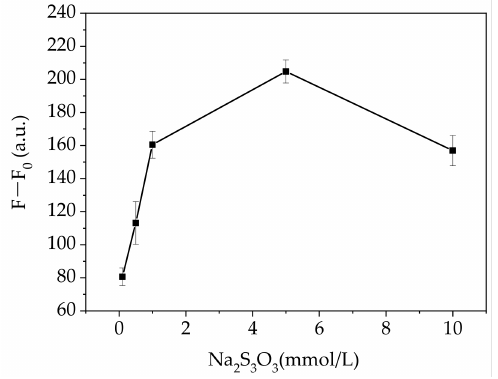
Figure 7. Effect of Na 2 S 2 O 3 concentration on Pb 2+ sensing.